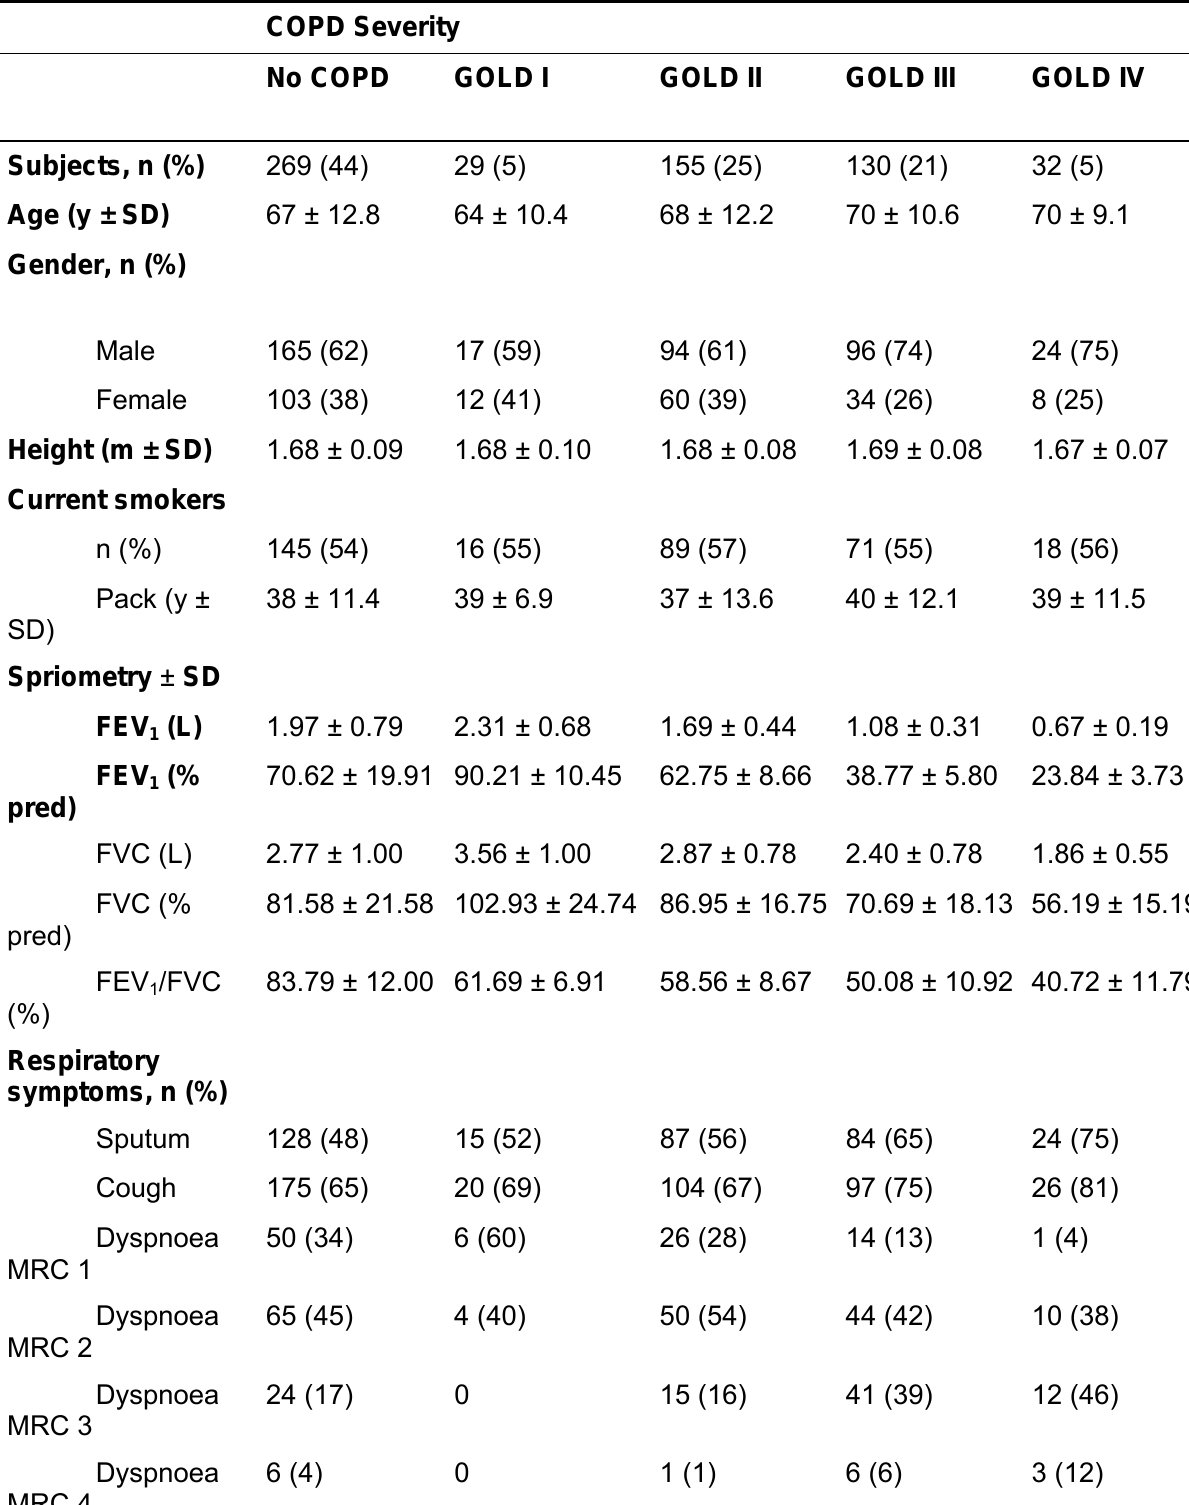
Demographic baseline spirometry and symptom